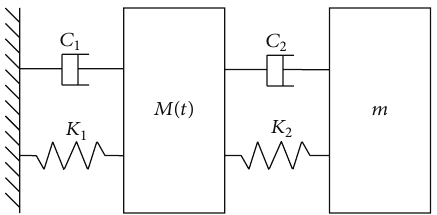
Figure 6: Schematic diagram of the 2-DOF system used in numer- ical